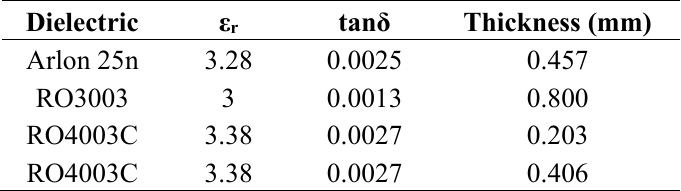
Table 2. Flexible dielectrics